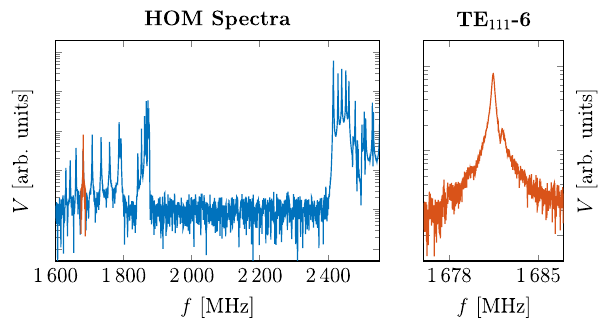
FIG. 7. Normalized beam-excited spectrum as recorded from a HOM coupler at ACC4 at FLASH. The left plot covers a wide frequency range including several monopole and dipole bands. The highlighted peak in the left plot and its magnification in the right one shows the TE 111 - 6 dipole mode used for the diagnostic. Note its double-peak character, indicating a frequency deviation between the two parts of the orthogonally polarized